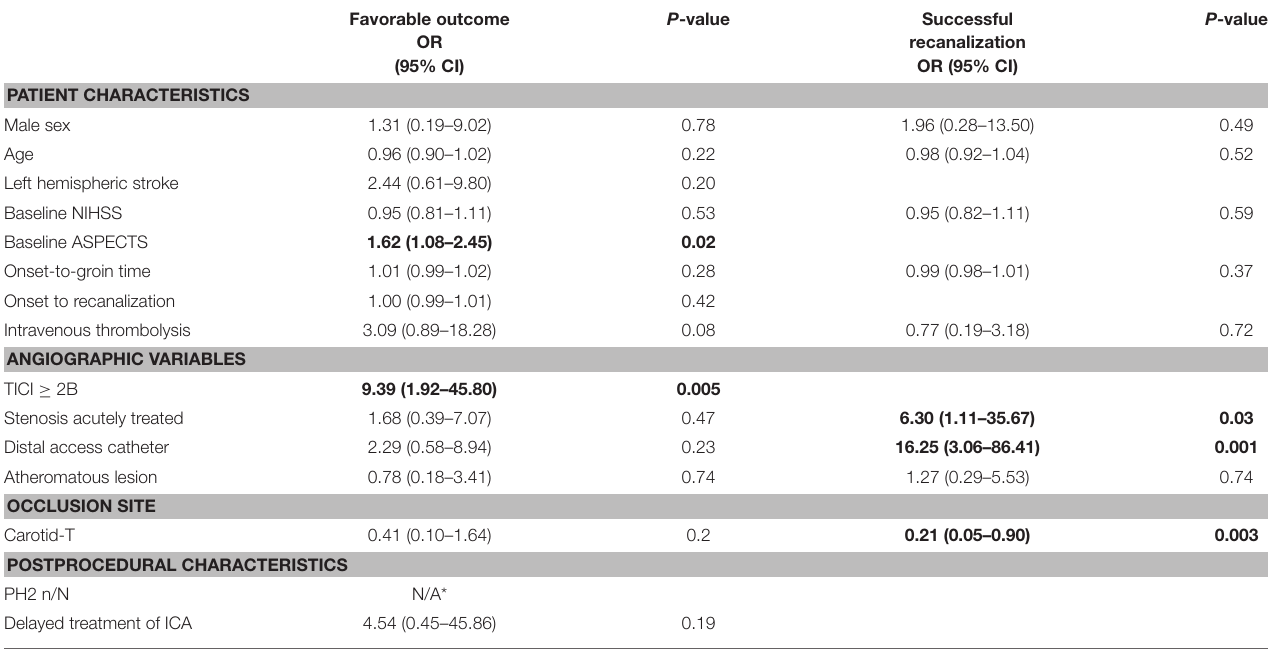
TABLE 3 | Univariate logistic regression analyses with odds ratios for favorable outcome and successful recanalization.